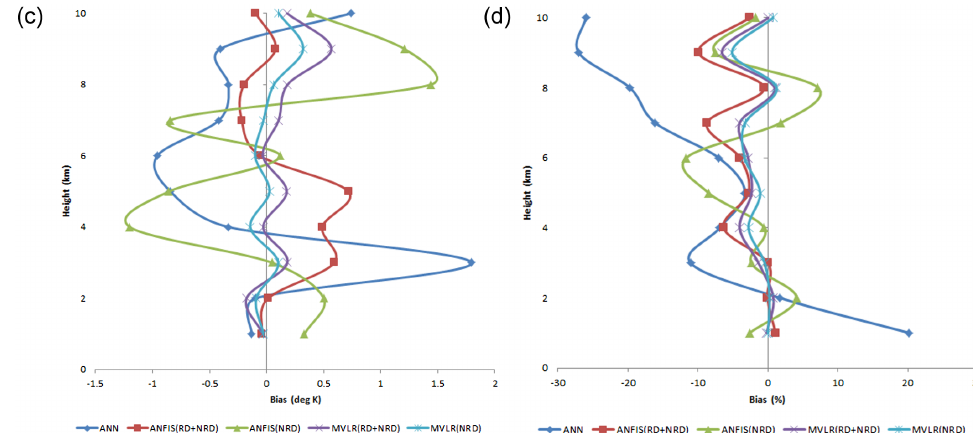
Figure 3. Scatter plot of difference between retrieved values of (a) temperature and (b) relative humidity using ANN, ANFIS(RD + NRD), ANFIS(NRD), MVLR(RD + NRD) or MVLR(NRD) techniques with radiosonde observations versus the retrieved values using these tech- niques respectively. Panels (c) and (d) are vertical distributions of bias in retrievals by different techniques for temperature and RH respec- tively. Table 2a. Multivariate regression coefficients and intercepts for temperature approximation at different height levels. Coefficients are derived using only non-rainy days